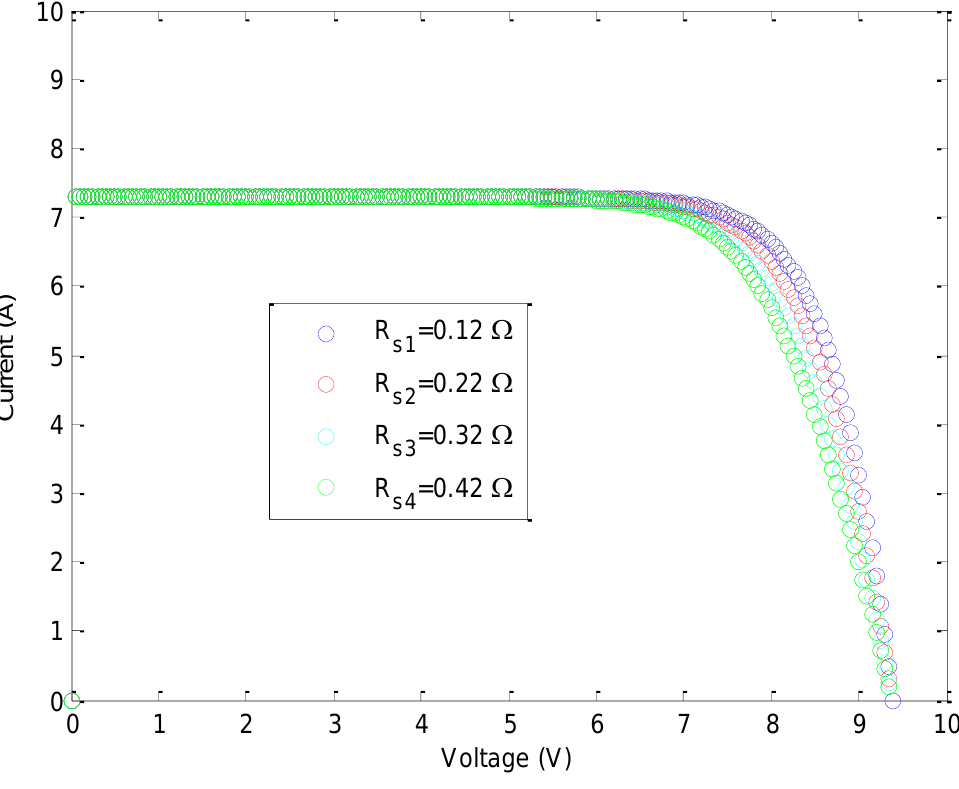
Figure 2. I-V characteristic curves for parametric variation of series